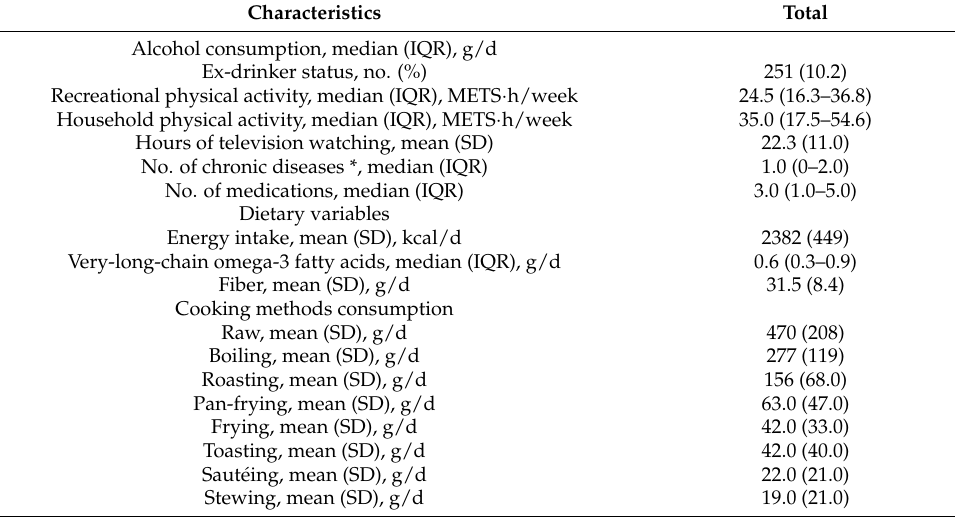
Characteristics